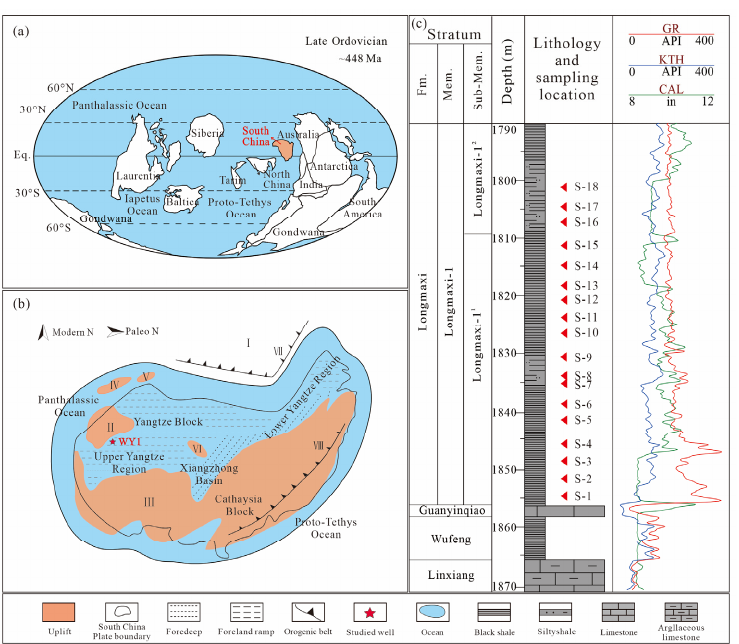
Figure 1. Geological setting of the study sections. ( a ) Late Ordovician global palaeogeographic map [19,38,39]; ( b ) Late Ordovician–Early Silurian Palaeotectonic–Palaeogeographic Map of South China Plate [40]. Notes: Ⅰ —North China Plate; Ⅱ —Chuanzhong Uplift; Ⅲ— Qianzhong Uplift; Ⅳ —Motian- ling uplift; Ⅴ —Hannan uplift; Ⅵ —Yichang uplift; Ⅶ— North Qinling orogenic belt; Ⅷ — Cathaysia orogenic belt. ( c ) Schematic stratigraphic log showing the sample locations.